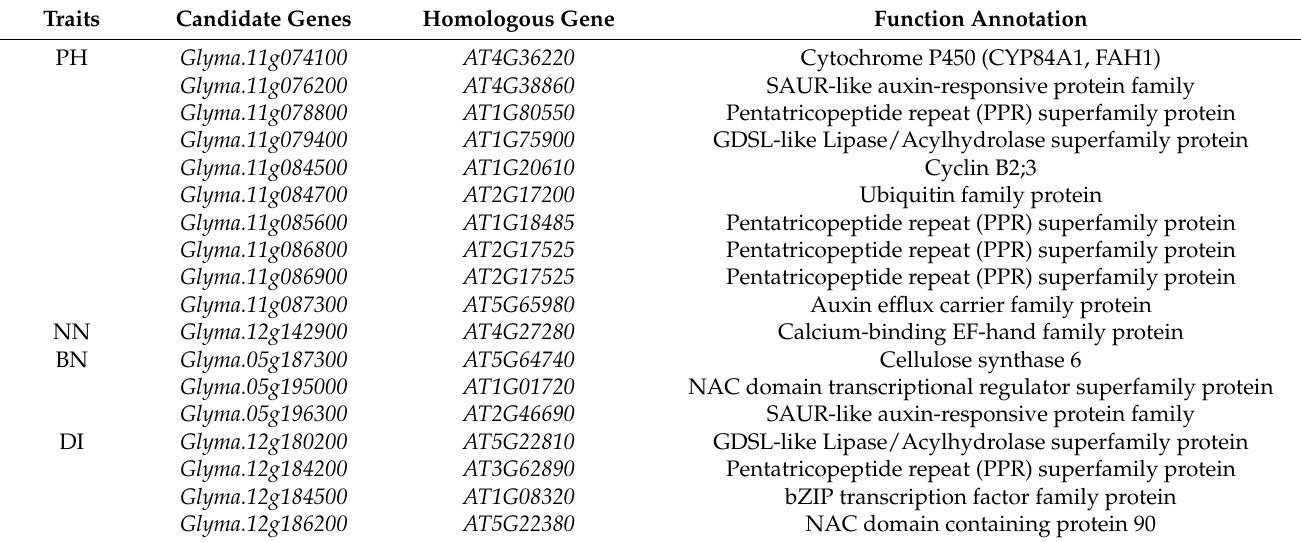
Table 4. Function annotation for candidate genes of plant architecture-related traits in